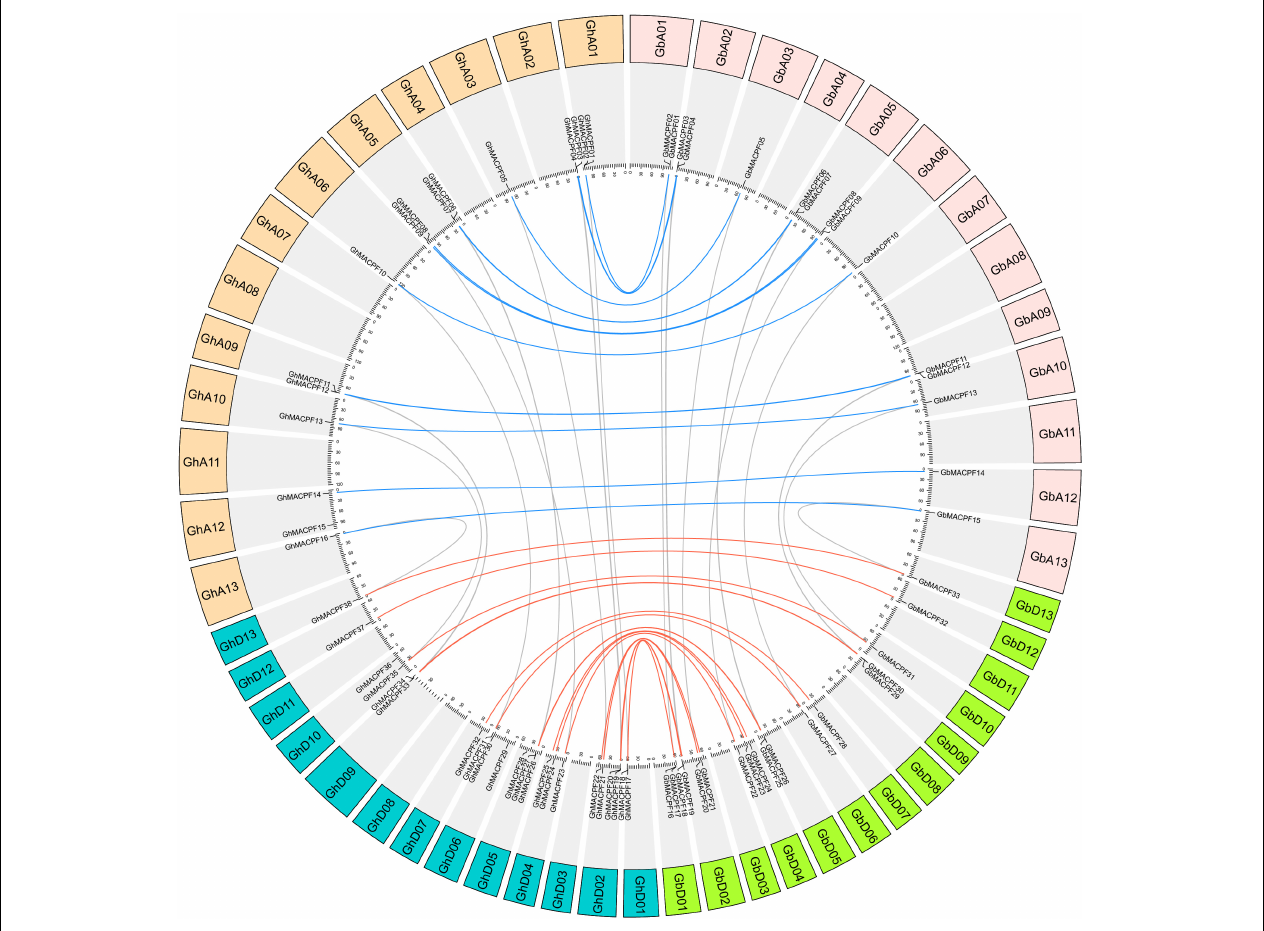
FIGURE 3 | Duplication event among the MACPF members between G . hirsutum and G . barbadense . The Blue line indicates the homologous genes between the Gh_At and Gb_At subgenomes and the red line indicates the Gh_Dt and Gb_Dt subgenomes.